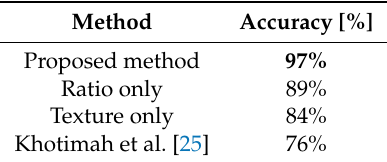
Table 4. Comparison of classification accuracy between the proposed method and an existing, previously published method of fish discrimination. The row ratio only is the result of classifying the image based only on the BLBS to fork length ratio. The row texture only is the result of just using texture features.